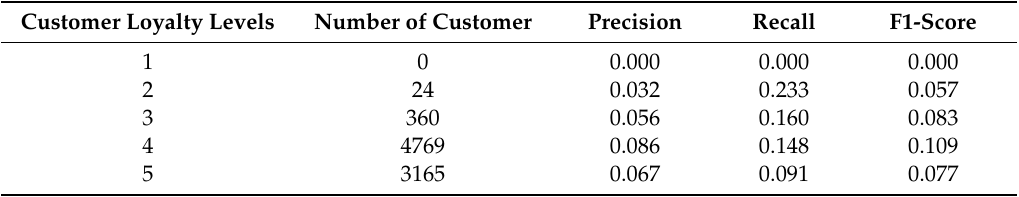
Table 3. Recommendation e ff ect of BGPR under di ff erent customer loyalty levels.